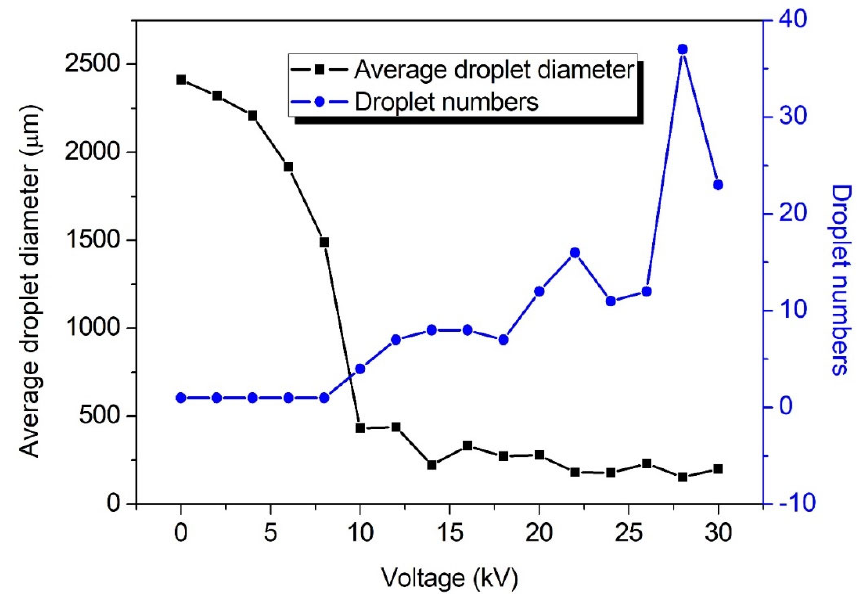
Figure 4. The numbers of breakup droplets and the average droplet diameters at different voltages (21G nozzle, flow rate of 400 mL/h, 35 wt. % concentration). (21G nozzle, flow rate of 400 mL/h, 35 wt. %